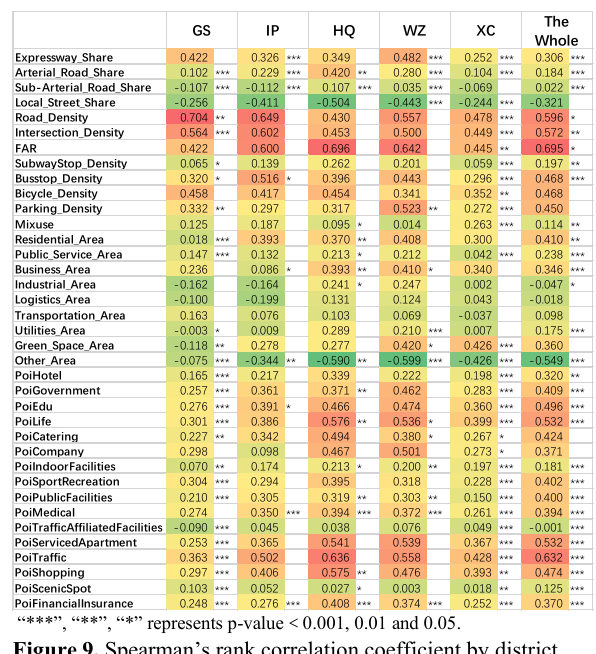
Figure 9. Spearman’s rank correlation coefficient by district